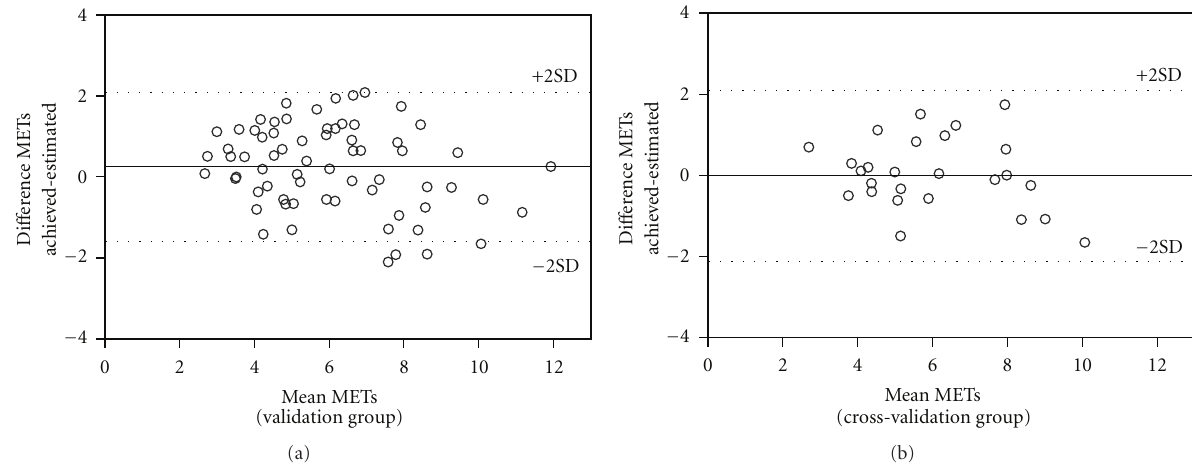
Figure 2: Bland Altman plot for predicted and actual CRF in both validation and cross-validation